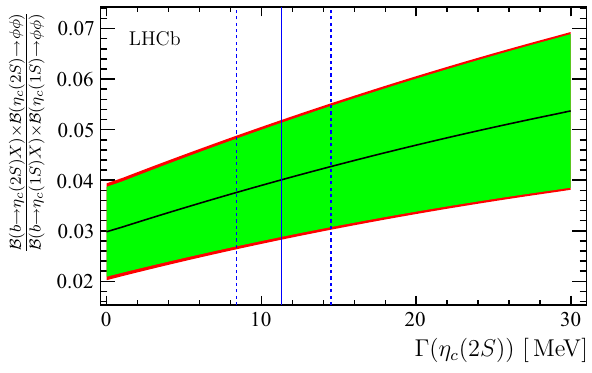
Fig. 5 Ratio of the η c ( 2 S ) and η c ( 1 S ) inclusive yields B ( b → η c ( 2 S ) X ) × B (η c ( 2 S ) → φφ) B ( b → η c ( 1 S ) X ) × B (η c ( 1 S ) → φφ) as a function of the assumed natural width. Statistical ( green band ) and total uncertainties are shown separately. The η c ( 2 S ) natural width from Ref. [14] is shown as a vertical solid line ; the dashed lines indicate its